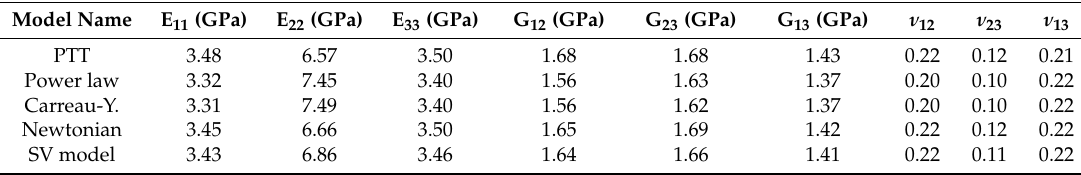
Table 4. Averaged elastic properties of the printed